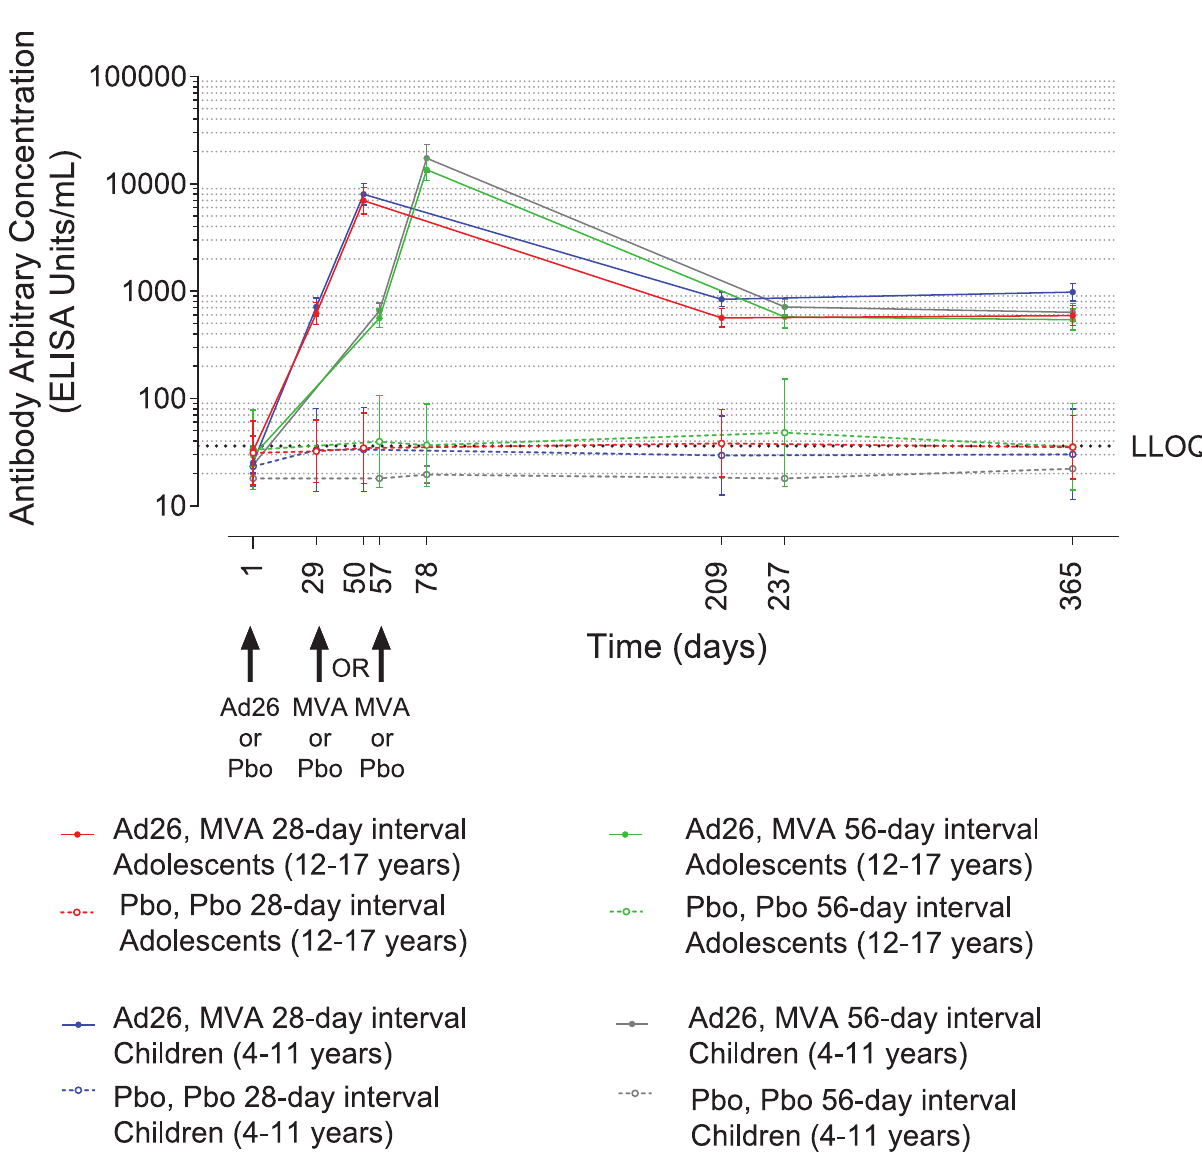
Fig 3. GMCs of EBOV-specific binding antibodies (FANG ELISA, 95% CI) in adolescents and children. Participants administered with Ad26. ZEBOV or placebo on day 1 and MVA-BN-Filo or placebo 28 or 56 days later as indicated. Responses are expressed as GMCs (EU/mL, 95% CI). Responses in placebo groups are shown as open symbols. Grey dotted line represents the LLOQ. The points (symbols) denote GMCs, and error bars denote 95% CIs. Ad26, Ad26.ZEBOV; CI, confidence interval; EBOV, Ebola virus; EU, ELISA units; FANG ELISA, Filovirus Animal Nonclinical Group enzyme-linked immunosorbent assay; GMC, geometric mean concentration; LLOQ, lower limit of quantification; MVA, MVA-BN-Filo; Pbo, placebo.